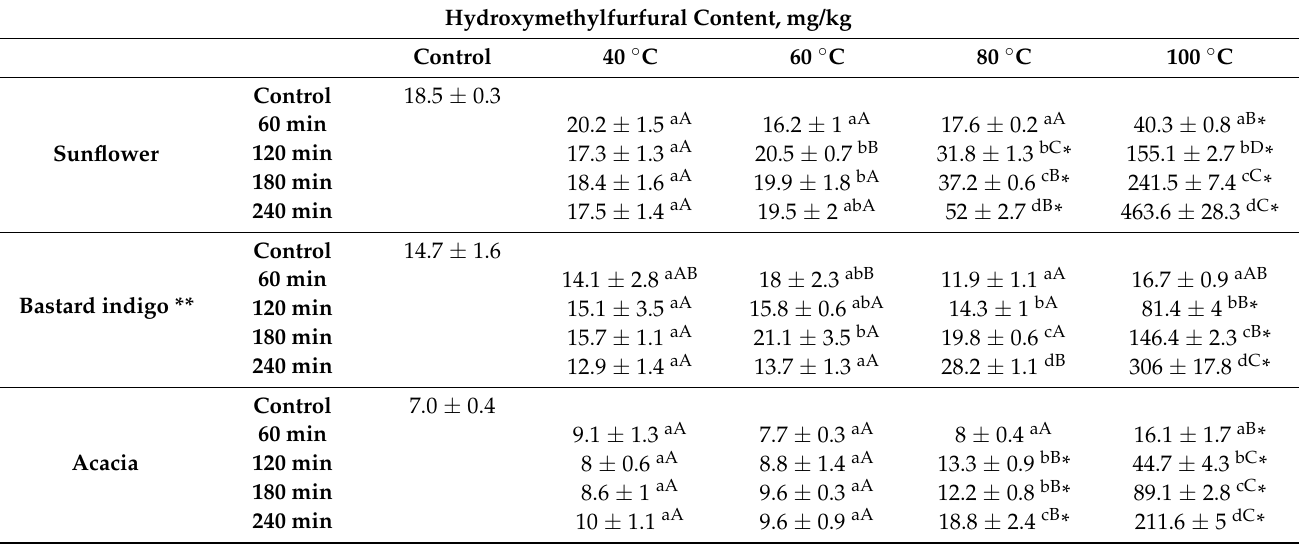
Table 1. Results of the HMF content of the honey samples from the heat treatment experiment. Hydroxymethylfurfural Content, mg/kg Control 40 ◦ C 60 ◦ C 80 ◦ C 100 ◦